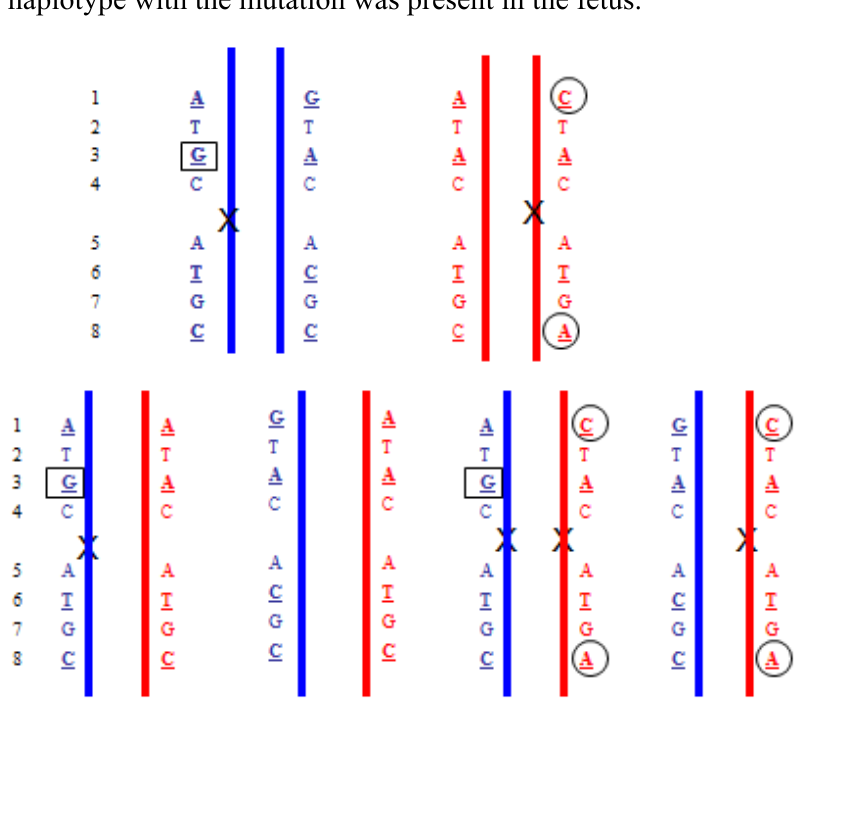
Figure 2. Segregation of an autosomal recessive disorder. Blue indicates paternal chromosomes and red maternal chromosomes. Upper shows the haplotypes for the parents and the lower shows the four different segregation possibilities. X denotes a disease mutation. The identification of the boxed G SNP in the maternal plasma would indicate that the paternal haplotype that carries the mutation was present in the fetus. An excess of the circled C and A SNPs in the maternal plasma (relative to the A and C) would indicate the maternal haplotype with the mutation was present in the